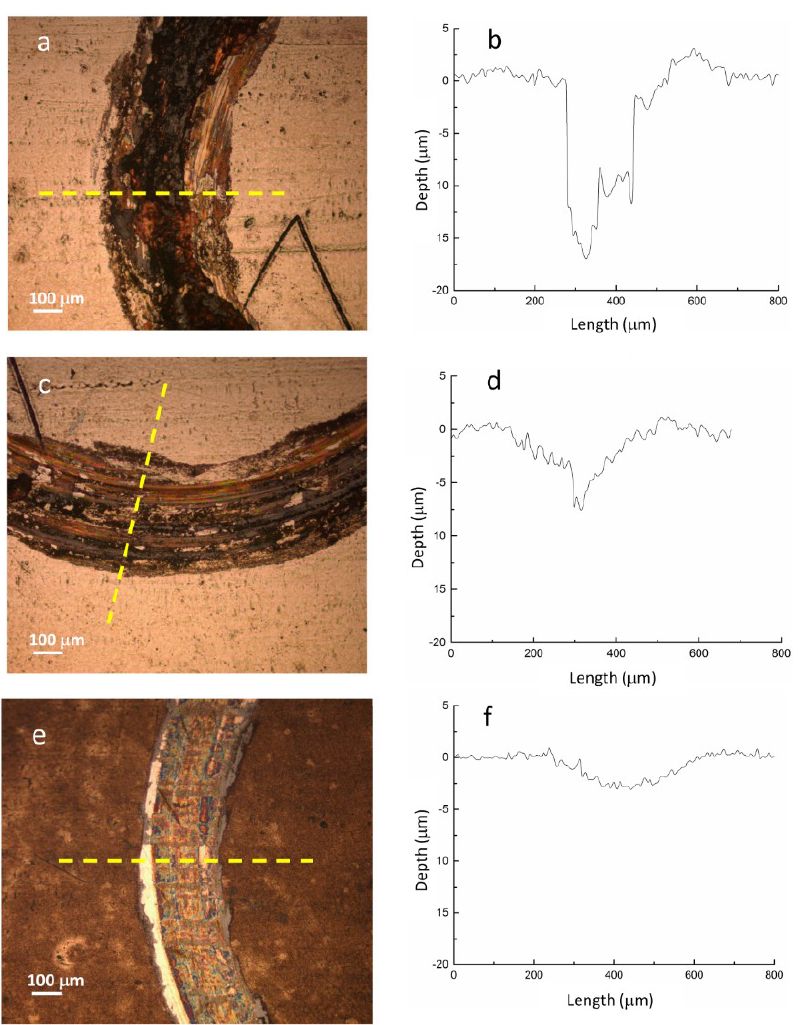
Figure 7. Optical micrographs of ( a ) a cracked area in the wear track of the as-deposited Fe-24W sample, and ( b ) surface profile acquired at the location of the dashed line in (a). Optical micrographs of ( c ) a crack-free area in the wear track of the as-deposited Fe-24W sample, and ( d ) surface profile acquired at the location of the dashed line in (c). Optical micrographs of ( e ) the wear track of the Fe-24W sample annealed at 800 °C, and ( f ) surface profile acquired at the location of the dashed line in (e).